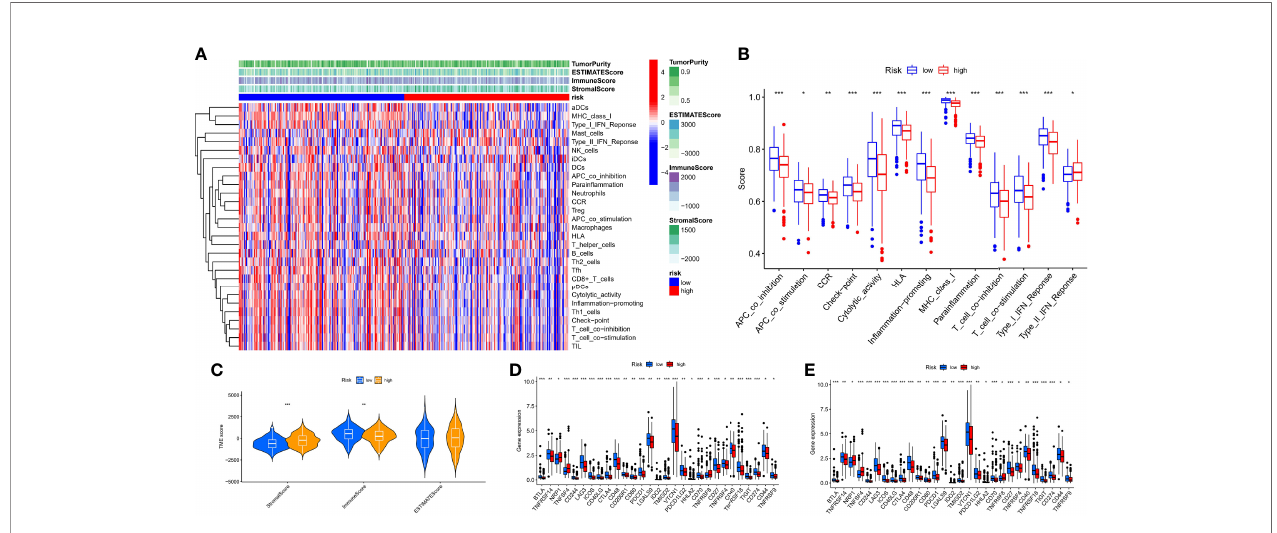
FIGURE 8 | Characteristics of the immune microenvironment in different risk groups. (A) Heat map of the result of ssGSEA and ESTIMATE algorithm. (B) Analysis of differences in the immune function of different risk groups. (C) Analysis of differences in TME score of different risk groups. (D) Analysis of differences in immune checkpoint mRNA expression of different risk groups. (E) Analysis of differences in HLA mRNA expression of different risk groups. * p < 0.05, ** p < 0.01, *** p < 0.001.